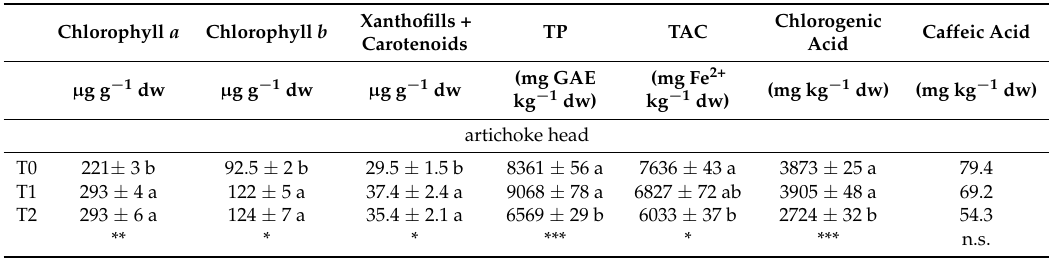
Table 6. Effect of cutting type used for the artichoke vegetative propagation on pigments and antioxidant compounds. Chlorophyll